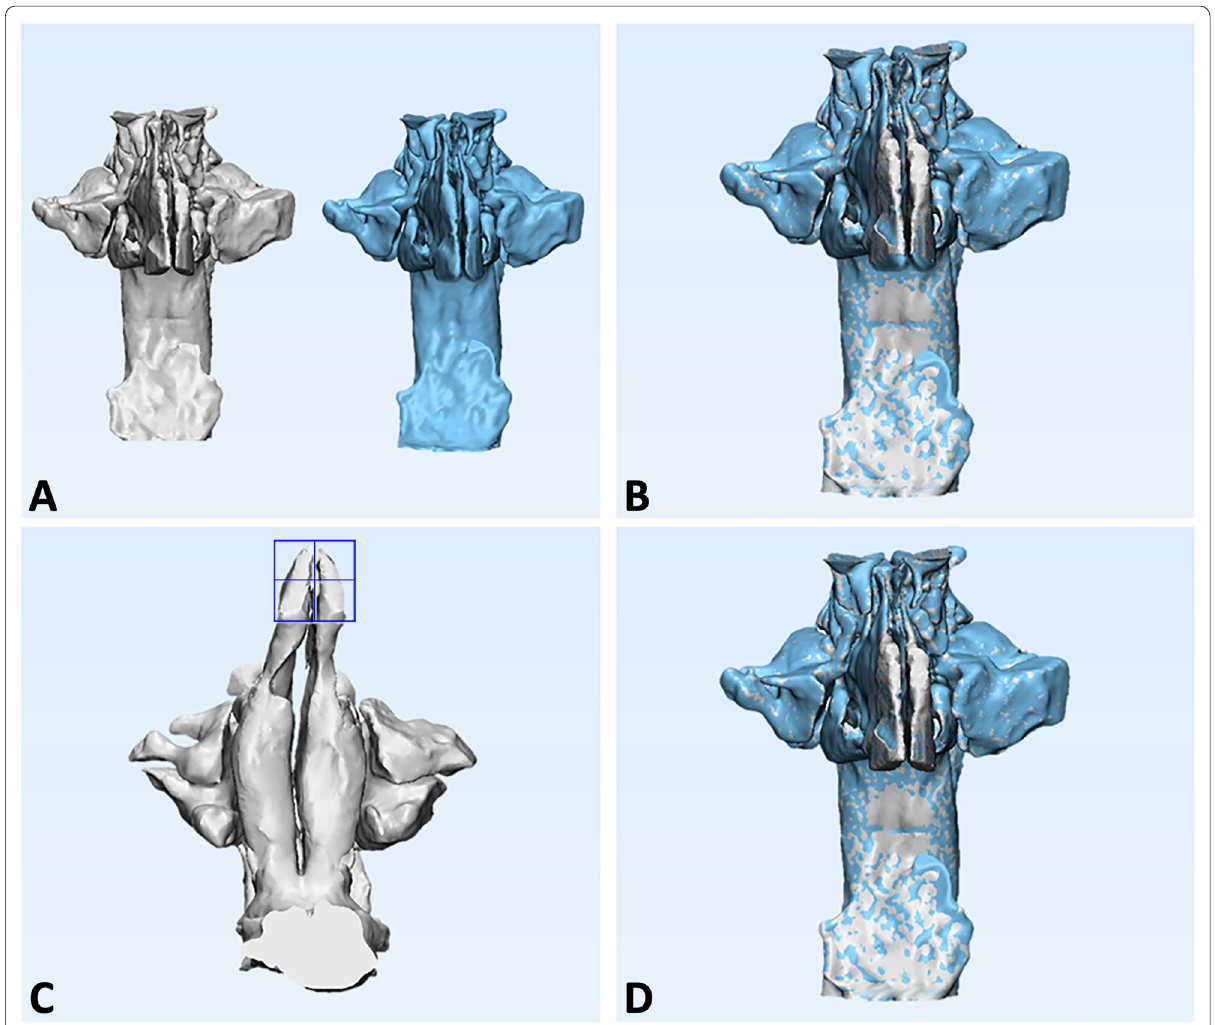
Fig. 4 Each 3D upper airway model obtained from semi-automatic segmentation was superimposed to its ground truth model (manual segmentation) in order to reliably remove the lowermost area of the nostrils. A , B ) Superimposition between GS and semi-automatic models, using a global surface-based registration method; C , D ) Cutting plane for exclusion of the lowermost area of the